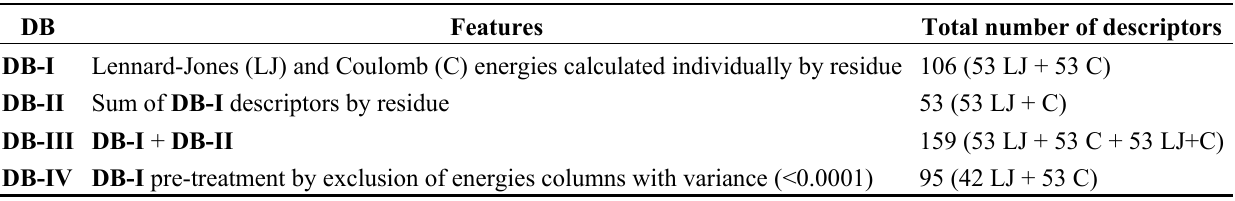
Table 2. Summary of features of the four databases ( DB ) used in the ReLIE-3D-QSAR